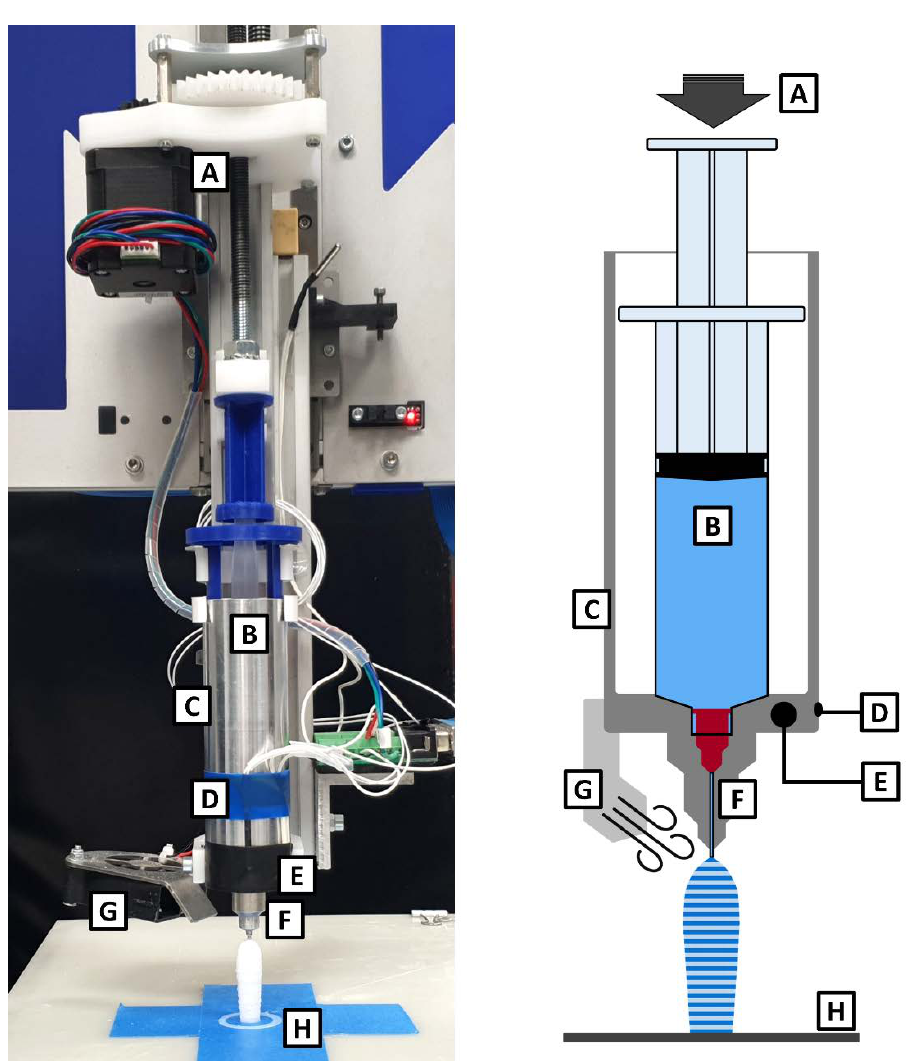
Figure 3. Photographic and schematic image of the 3D printer equipped for semi-solid 3D printing: ( A ) force on syringe piston applied by a motorized threaded rod, ( B ) 10 mL syringe filled with drug- loaded suppository base, ( C ) heatable metal cylinder, ( D ) thermistor, ( E ) heat cartridge, ( F ) heated nozzle, ( G ) cooling fan, ( H ) printing plate equipped with blue tape.